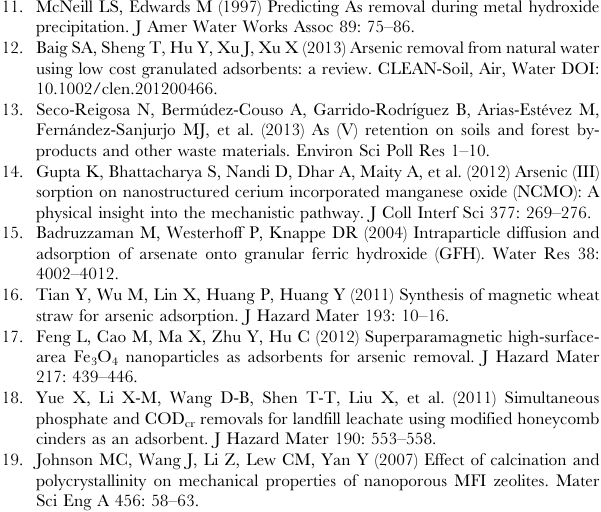
Figure S1 HT-XRD patterns of the adsorbent composite (Fe 3 O 4 -HBC-1000 6 C(N 2 ) heated at 1000 6 C. Different HT- XRD peaks are also marked.